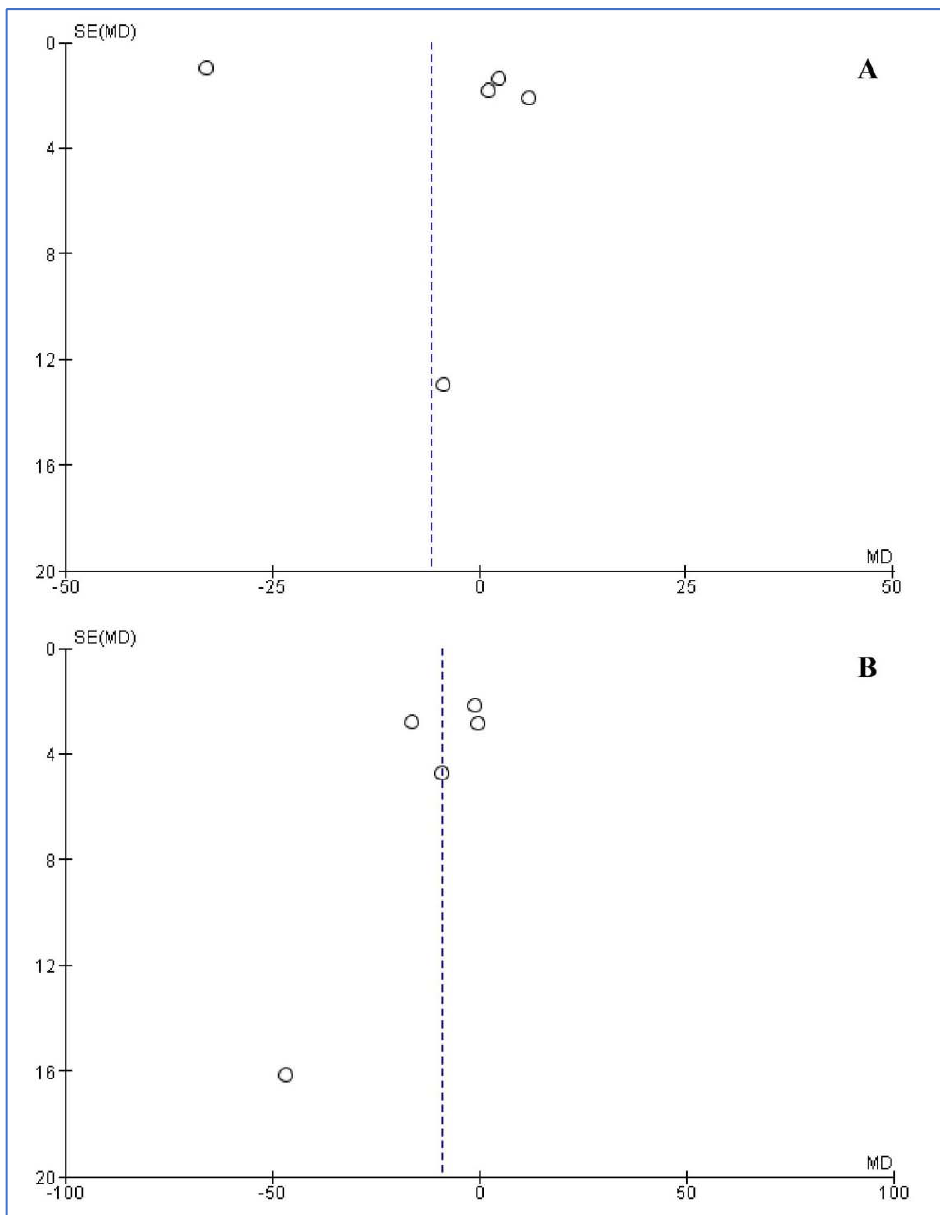
Figure 4. Funnel plots of included studies reporting salivary iron ( A ) and serum ferritin ( B ) levels.